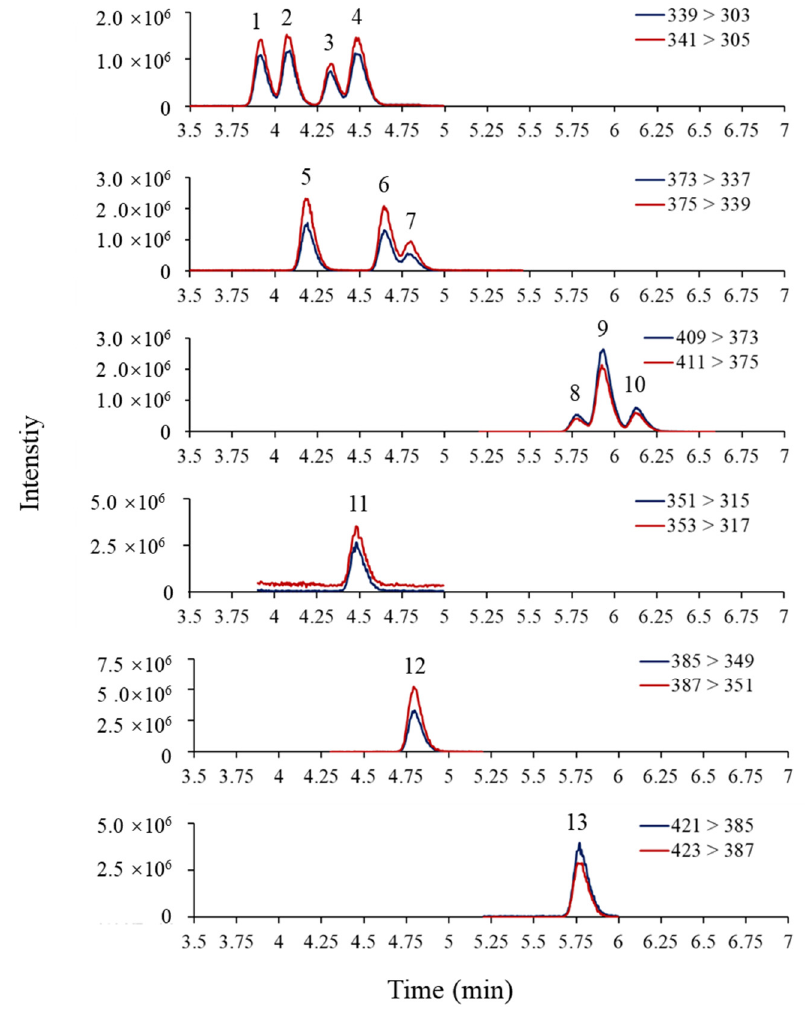
Figure 3. MRM chromatograms of OH-PCBs (10 ng/mL) and their 13 C- labeled standards (20 ng/mL) under optimized instrumental conditions. 1: 3 ′ -OH-PCB101, 2: 4 ′ -OH-PCB101, 3: 3-OH-PCB118, 4: 4-OH-PCB107, 5: 3-OH-PCB153, 6: 4-OH-PCB146, 7: 3 ′ -OH-PCB138, 8: 4-OH-PCB187, 9: 3 ′ -OH-PCB180, 10: 4`-OH-PCB172, 11: 13 C 12 -4-OH-PCB107, 12: 13 C 12 -4-OH-PCB146, 13: 13 C 12 -4-POH- CB187.